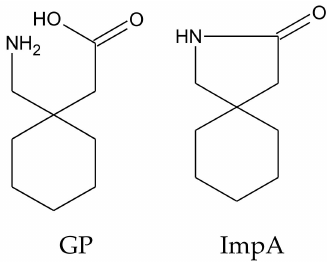
Figure 1. Chemical structures of Gabapentin (GP) and impurity A (impA). Although the structures of GP and ImpA are similar, signal overlap on the 1 H spectrum can only observed be in the cyclohexane fragment range (1.25–1.70 ppm). Methylene group signals are differentiated: CH 2 -N δ = 3.02 ppm (GP) and 3.24 ppm (ImpA); CH 2 -C=O δ = 2.45 ppm (GP) and 2.28 ppm (ImpA). It should be noted that signals of the ImpA do not overlap with 13 C satellites of GP signals (Figure 2).